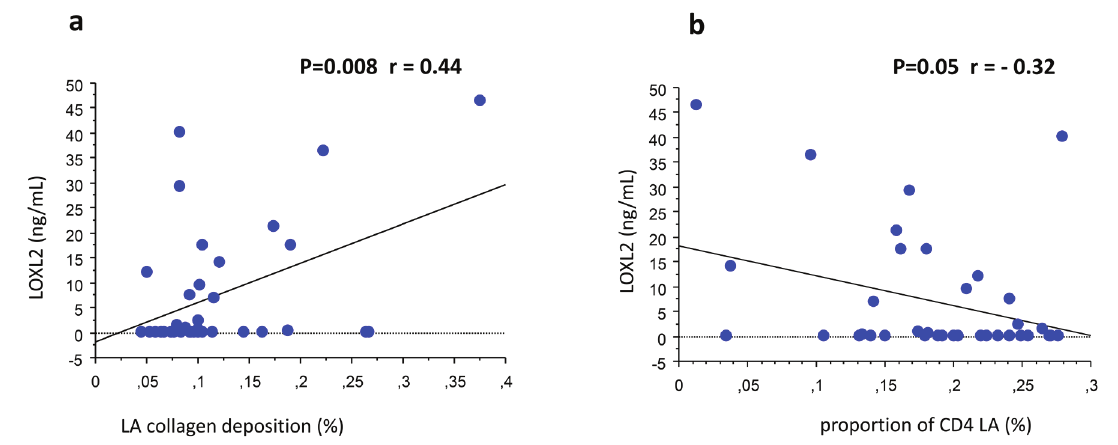
Figure 2. Circulating LOXL2 level correlates with (a) lymphoid aggregate (LA) collagen deposition and (b) CD4+ lymphoid agregate. X axis: percentage of lymphoid aggregate collagen deposition (%) Y axis: level of LOXL2 (ng/mL) Figure legends 2b: X axis: proportion of CD4 lymphoid aggregate (%) Y axis: level of LOXL2